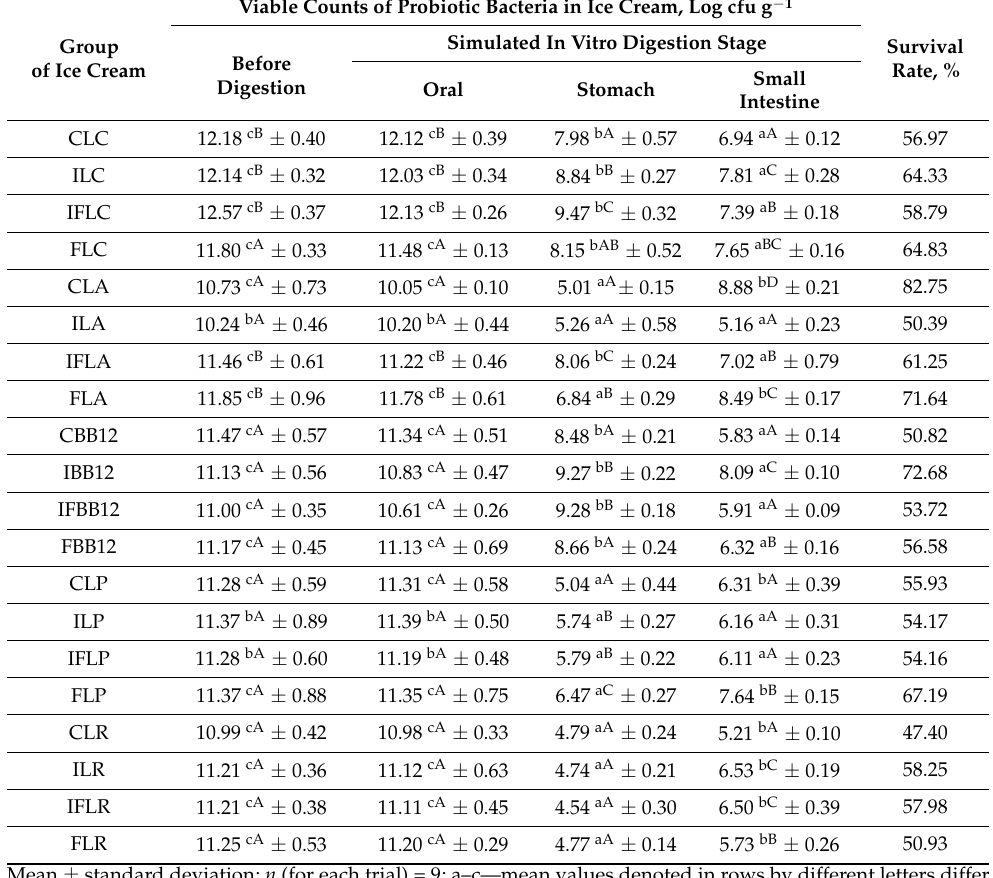
Table 2. Survival [%] and viable counts of probiotic bacteria in ice cream (log cfu g − 1 ) before and during simulated in vitro